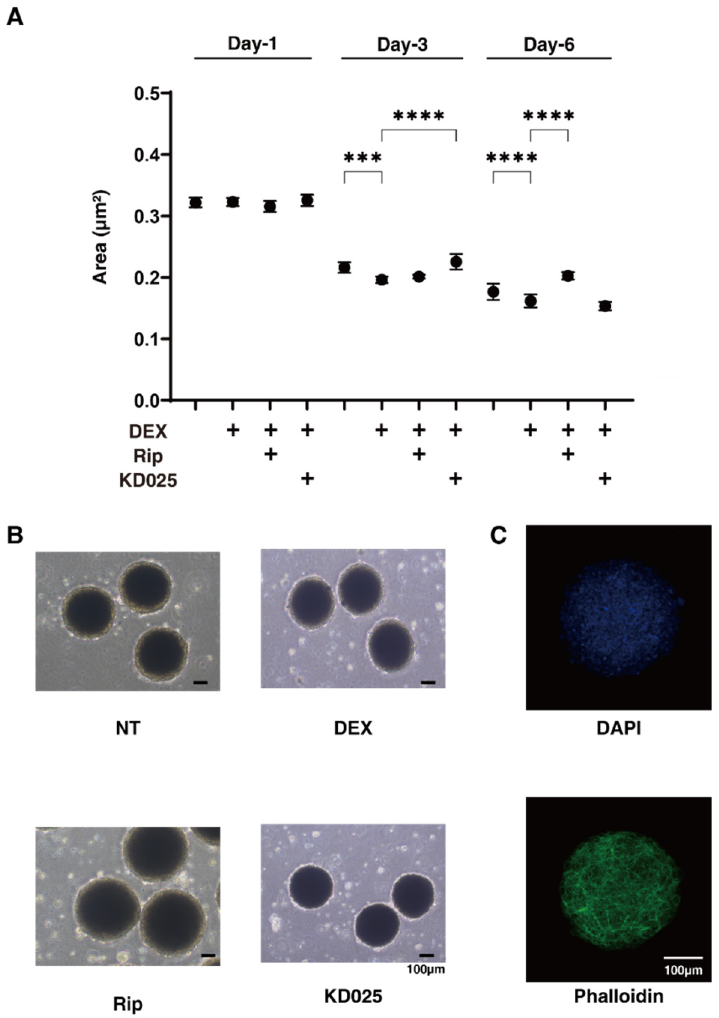
Figure 2. Changes in DEX-treated 3D HTM spheroid size at Days 1, 3, or 6 in the presence and absence of ripasudil or KD025, and a representative non-treated 3D spheroid image stained with DAPI and phalloidin ( C ). At Days 1, 3, or 6, the mean sizes of HTM 3D spheroids (non-treated